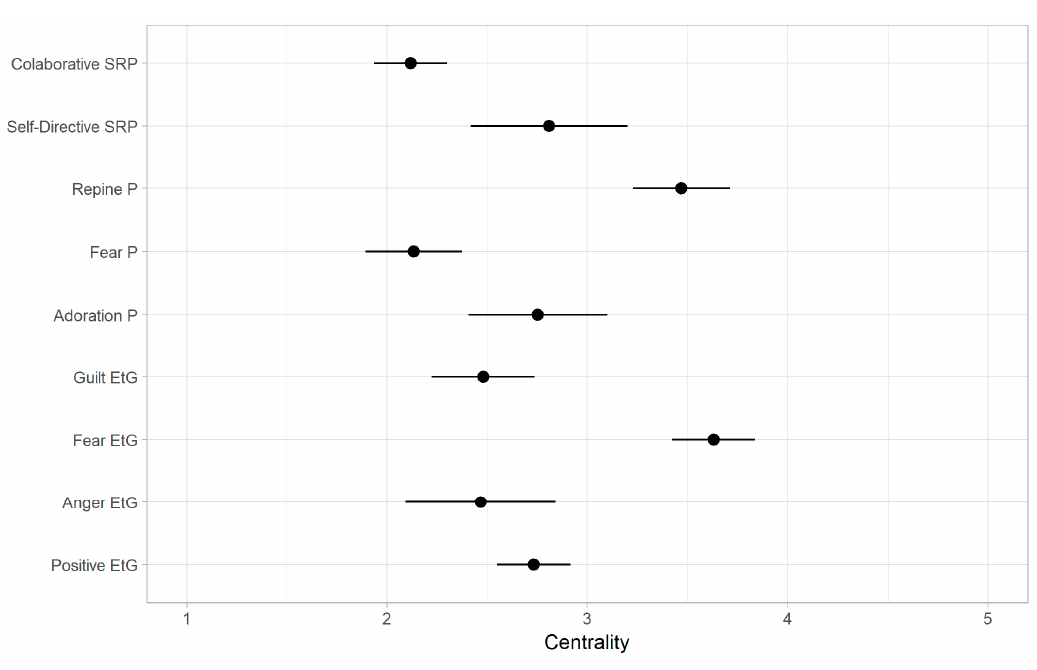
Figure 3. Estimates of changepoints in segmented regressions and their 95% confidence intervals.